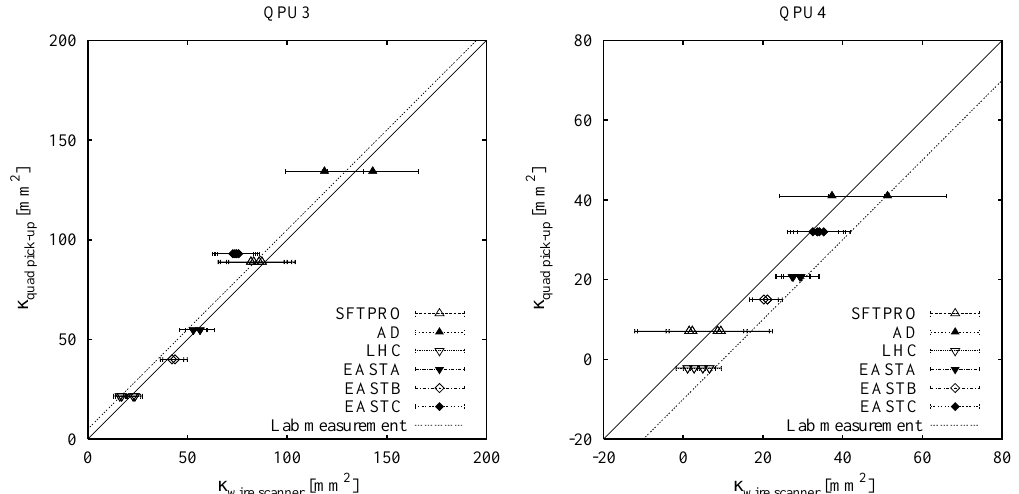
FIG. 4. Comparison between the measured value from the two quadrupole pickups and the expected results calculated from the emittances measured with the wire scanners. The solid line is the ideal case, and the dotted line includes pickup offsets measured in the lab prior to installation. All possible ways of combining the wire-scanner measurements are displayed. Note that the cases where the two wire-scanner results are inconsistent also are cases with large estimated systematic